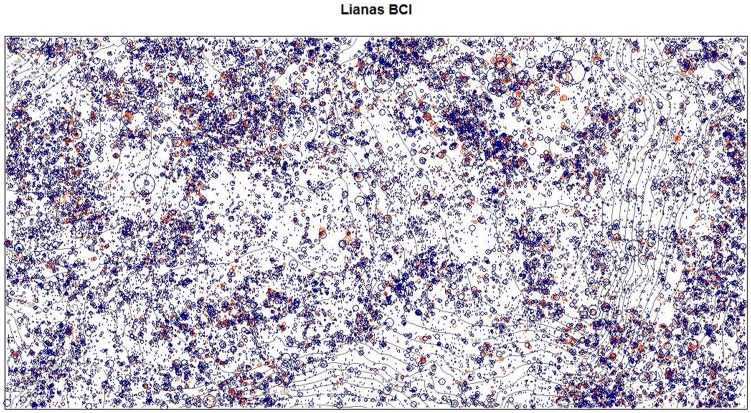
The rooted liana stems (≥1 cm diameter) in the Barro Colorado Island, Panama 50-ha plot.The plot is 1000 m on the x-axis and 500 m on the y-axis. Blue circles denote principal stems and orange circle indicate clonal stems that are rooted in the plot but still attached to a principal stem. Basal area is indicated by the size of the circle, with the largest liana 55.1 cm diameter and the smallest lianas 1 cm diameter.